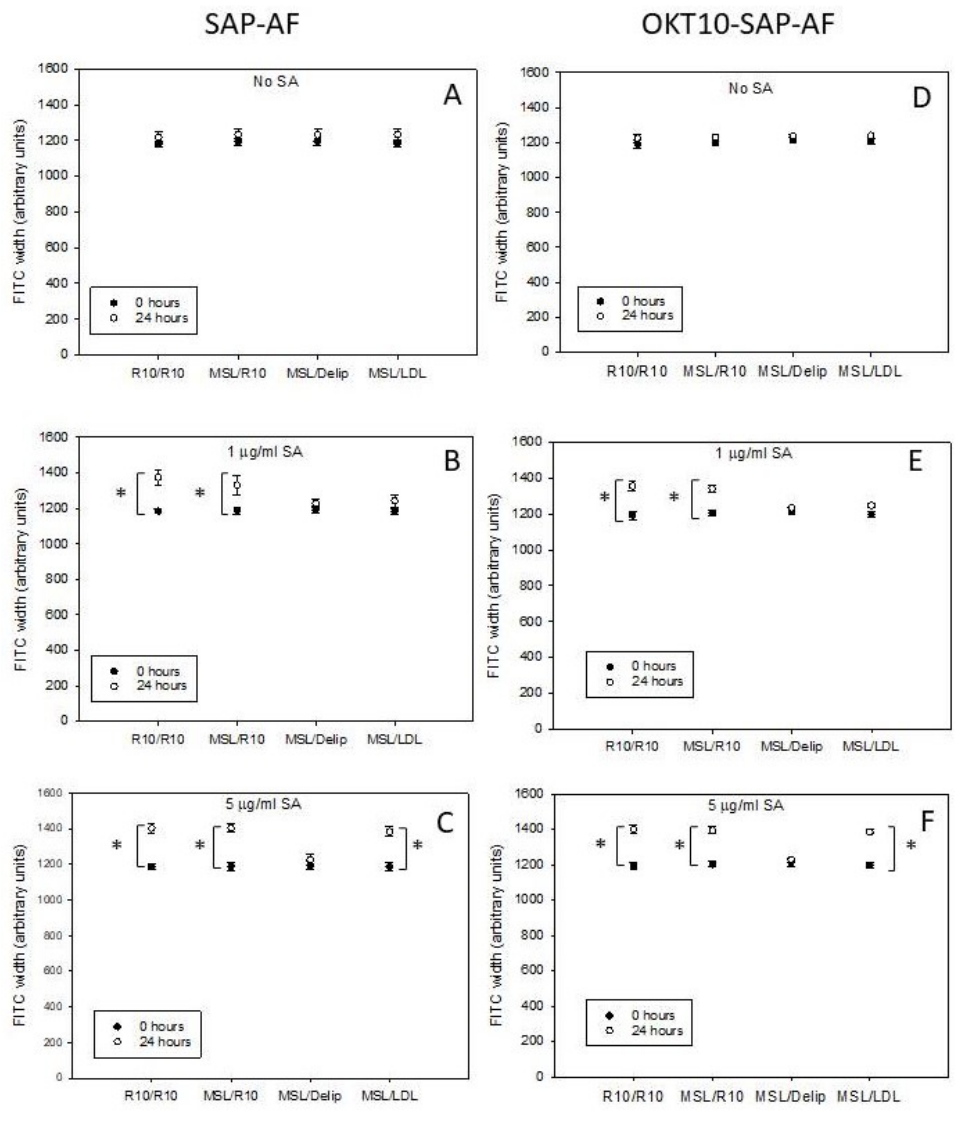
Figure 4. Low density lipoprotein (LDL) repletion of lipid deprived Daudi cells restores the endolysosomal escape of OKT10-SAP-AF and SAP-AF in the presence of 5 µ g / mL SA. FITC width values for lipid deprived Daudi cells, lipid deprived cells repleted with LDL or R10 and mock-treated control cells after zero (black) and 24 (grey) hours for SAP-AF in the absence ( A ) or presence of 1 ( B ) and 5 ( C ) µ g / mL SA and for OKT10-SAP-AF in the absence ( D ) or presence of 1 ( E ) and 5 ( F ) µ g / mL SA. The data presented are the mean of three independent experiments and the error bars represent one standard deviation either side of the mean. * p < 0.005 as determined using the Mann–Whitney U test.